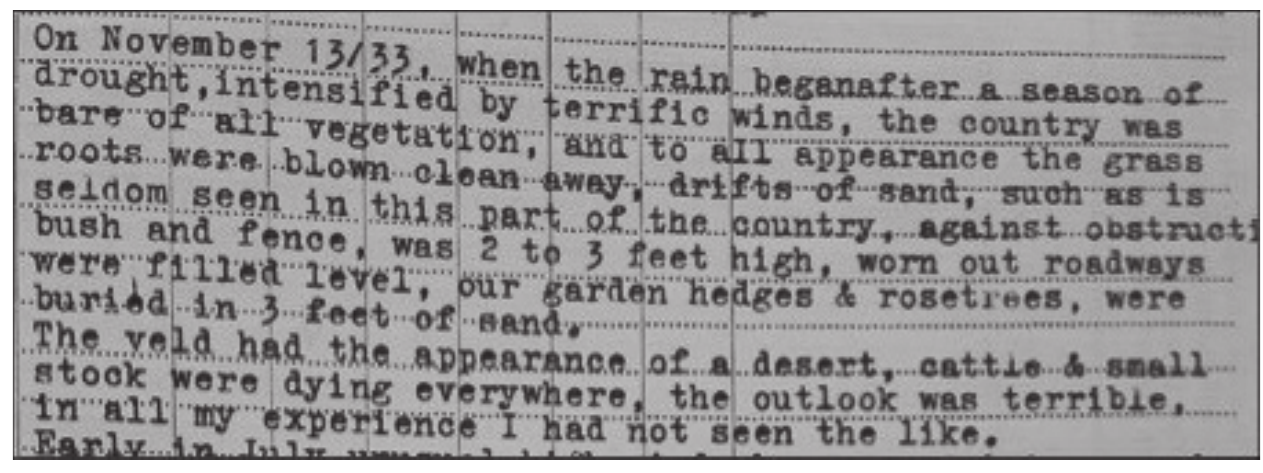
FIGURE 1: Dairy by Mr T.A. Young: The Miracle of